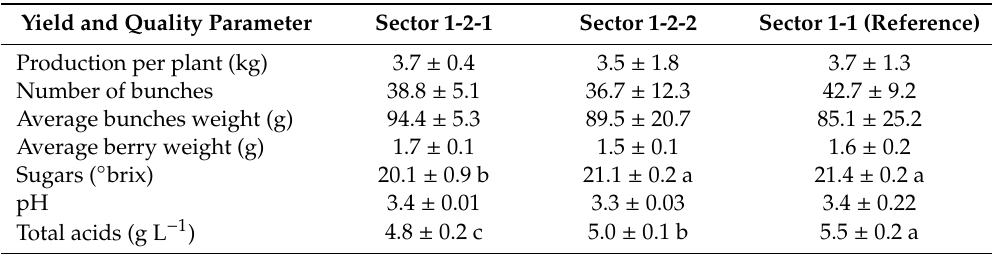
Table 7. Yield and quality parameters measured for the three sectors. Di ff erent letters denote statistically significant di ff erences between the sectors evidenced by Duncan’s